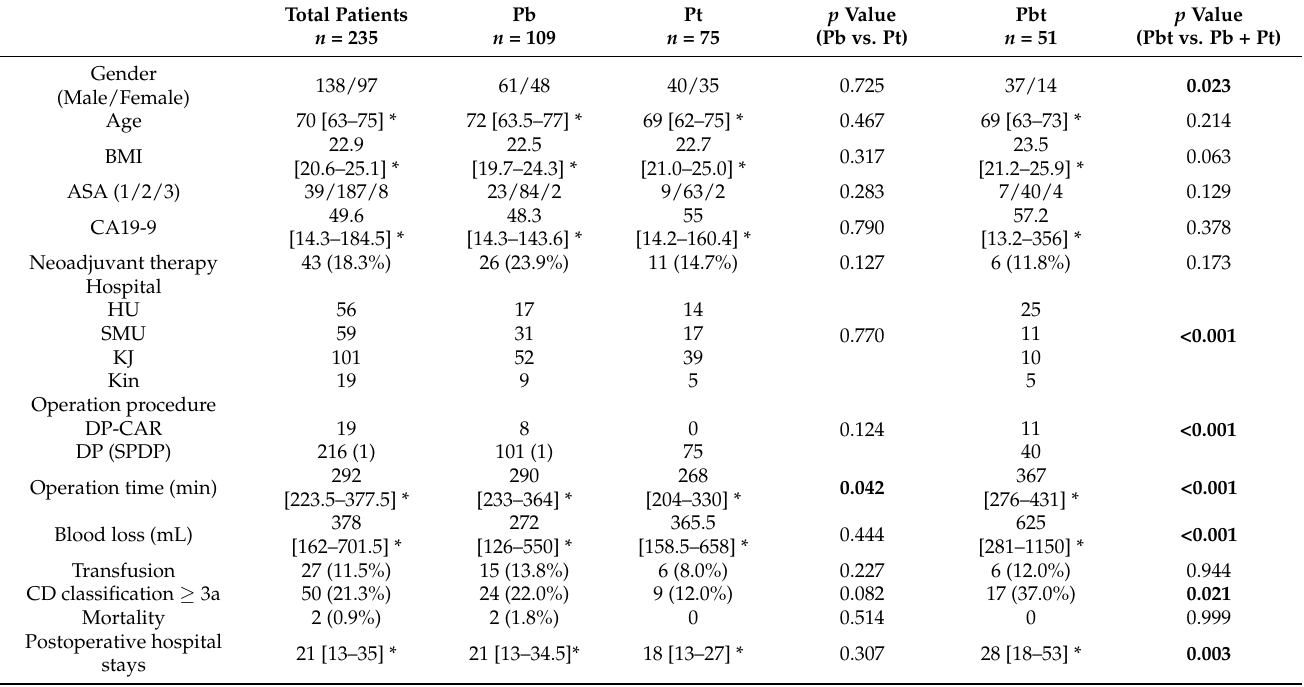
Table 1. Demographic and surgical characteristics of patients who underwent distal pancreatectomy for pancreatic